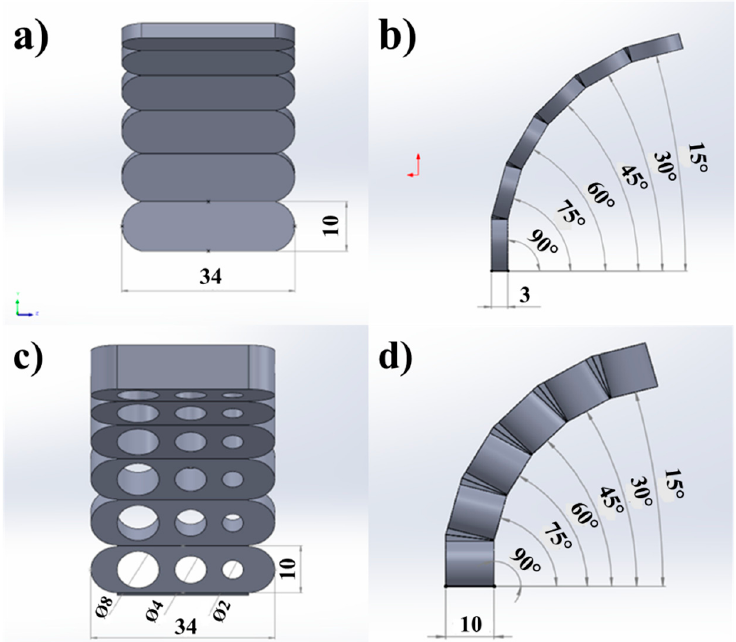
Figure 1. L-PBF structures considered for this work: the self-supported structure reported in ( a , b ) was considered for the surface quality assessment, whereas the one reported in ( c , d ) was considered for the hole quality assessment (quotes are reported in mm).